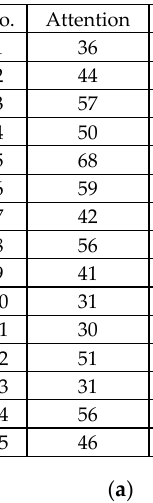
Figure 6. The sample sequence of the two-feature sample sequences measured by the brain wave device of the emotion type of calmness with average feature values of attention a = 51 and meditation m = 52 (note: the average feature values a and m satisfy the decision rule for calmness, namely, 30 ≤ a < 70 and 30 ≤ m < 70).